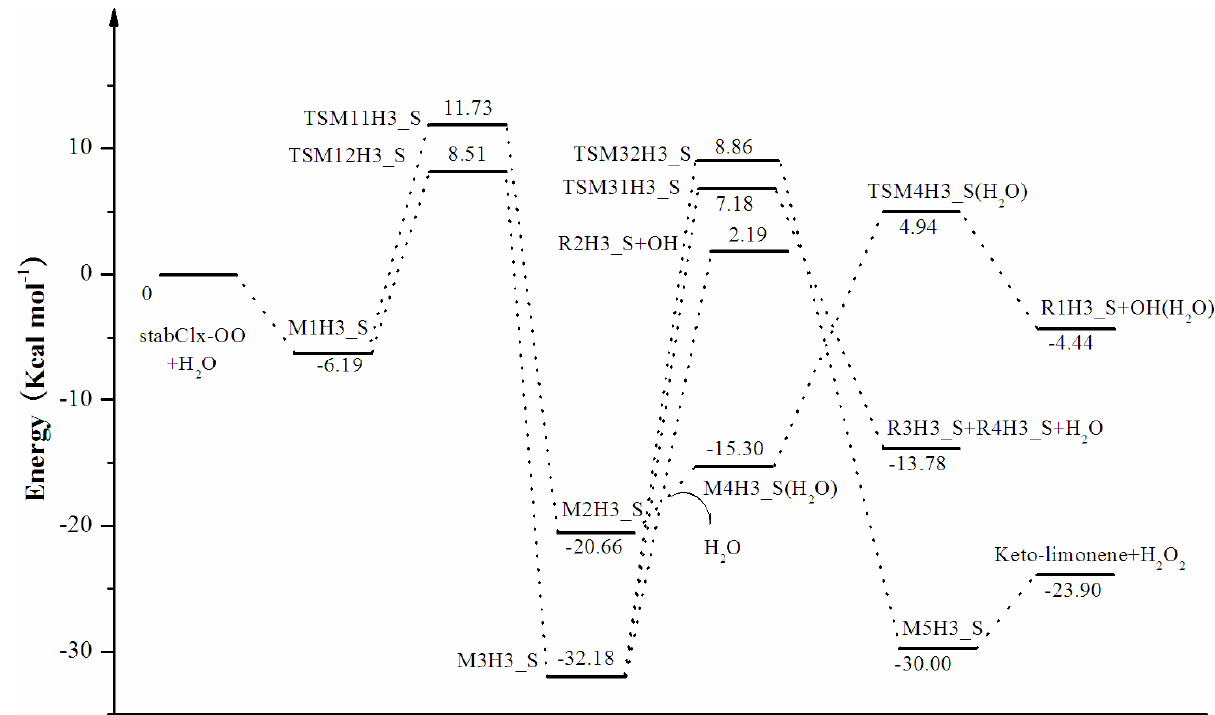
Figure 6. stabCI x -OO + H O reaction coordinates: relative energies of the stationary points 2 located on the separate stabCI x -OO and H O ground-state potential energy surface. The 2 energy values are given in kcal mol − 1 and are calculated using CCSD(T)/6-31G(d) + CF//B3LYP/6-31G(d,p)